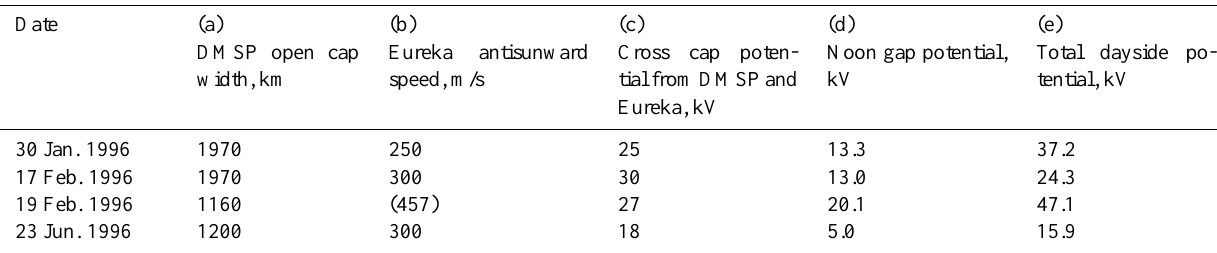
Table 1. Comparison of potentials from cusp and polar cap